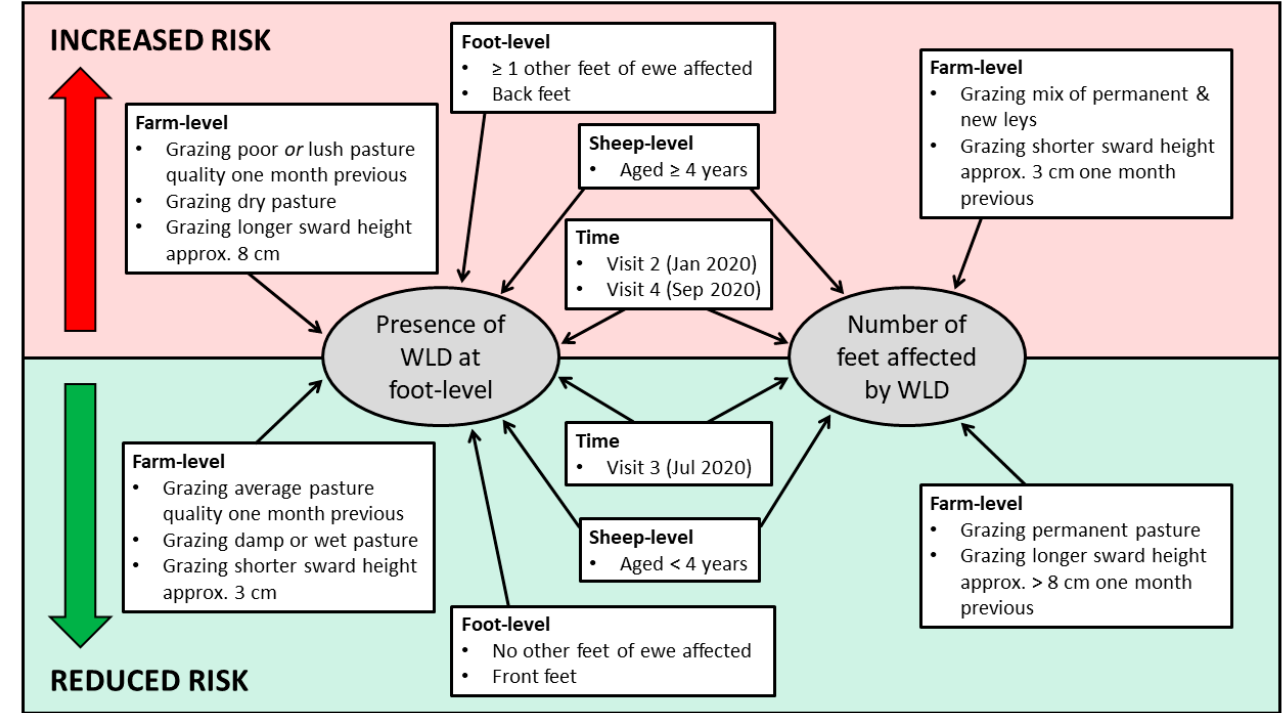
Figure 3. Summary of factors associated with the increased and reduced risk of white line disease at foot-level and the number of feet affected.